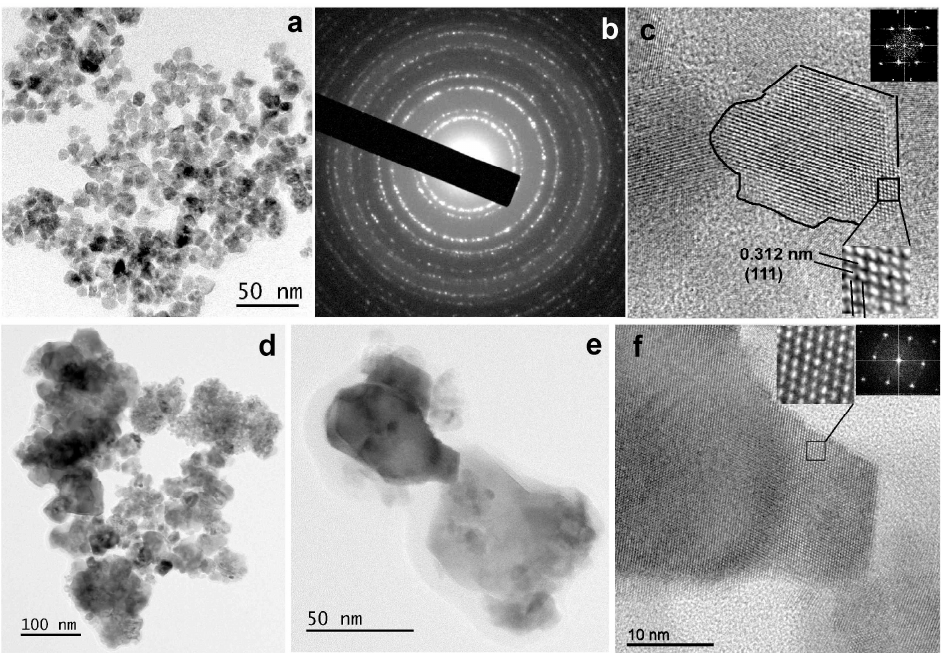
Figure 4. ( a ) TEM image illustrating the NPs recorder from the sample CeO1g. ( b ) the corresponding SAED ring pattern including the sequence of reflections of the cubic CeO 2 fluorite structure. ( c ) HRTEM image of a CeO1g NP with a magnified part, showing the atomic structure viewed along <110> zone axis, and the corresponding FFT as insets. ( d ) TEM image of the NPs consisting of the sample CeO5g. ( e ) TEM image of sample CeO5g illustrating two NPs with an average projected size of about 50 nm. ( f ) HRTEM image obtained from the darker, in contrast, NP of ( e ), viewed along the <110> zone axis. Magnified part of the image showing the two families of {111} lattice fringes and the corresponding FFT are given as insets.